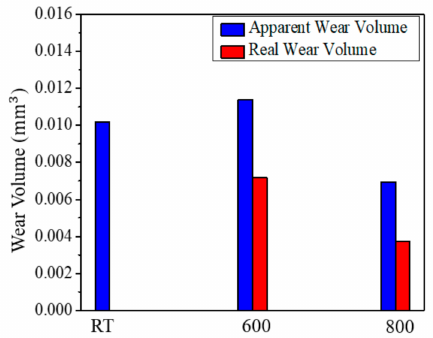
Figure 5. Apparent and real wear volumes after the sliding tests at RT, 600 and 800 ◦ C.